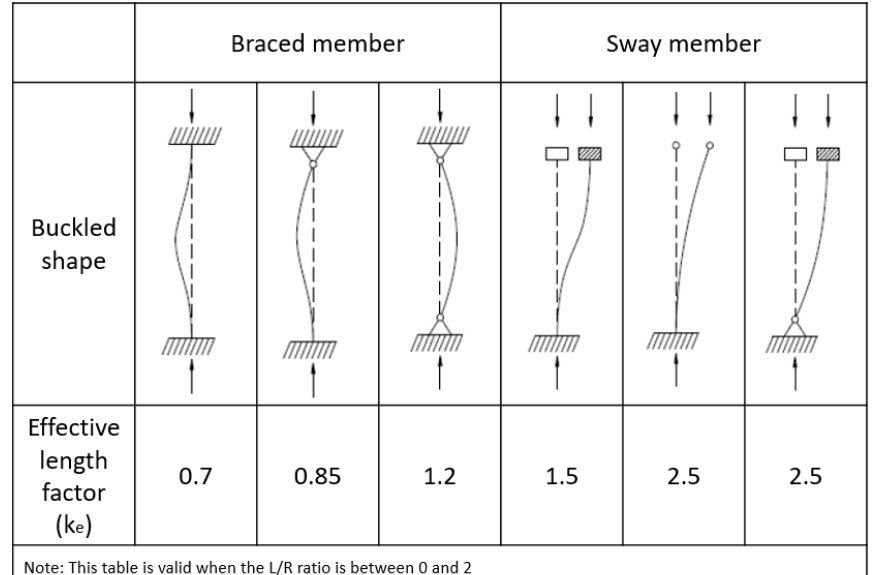
Figure 22. The proposed effective length factor for curved members.